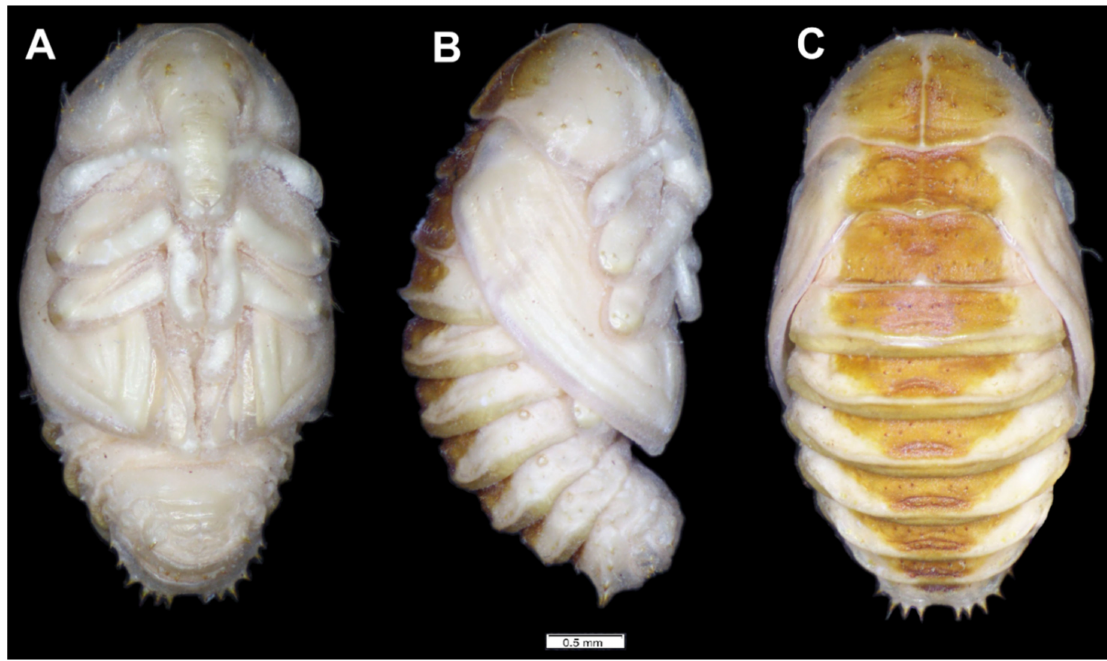
Figure 9. Lachnaeus crinitus habitus of pupa. ( A )—ventral view; ( B )—lateral view; ( C )—dorsal view. Chaetotaxy well-visible, with setae of various lengths from medium to short on the dorsal part of the body placed on prominent protuberances, especially on prothorax and abdominal segments VI and VII. Head with one pas , two os and two sos , rostrum without setae. All setae on head equal in length, short (Figure 10A–C). Pronotum with three as , three ls , two sls , three ds , and seven pls equal in length (Figure 10D). Each, meso- and metathorax with nine minute setae (three placed posteromedially, six along anterior margin). Each femora with two medium, hair-like setae (Figure 10A–C). Abdominal segments I–V with 11 minute setae (three placed posteromedially, eight placed along anterior margin of each of the segments) (Figure 10E). Abdominal segment VI with 11 setae (three minute placed posteromedially, eight short, placed on protuberances along anterior margin of the segment). Abdominal segment VIII with 10 setae: three minute placed posteromedially, four medium placed anteromedially and three short placed anterolaterally, d 4 – d 7 placed